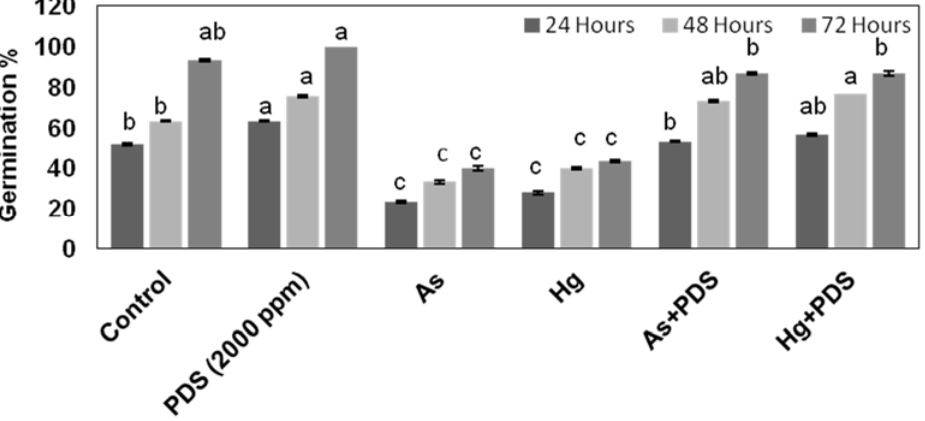
Figure 1. Effect of PDS (2000 ppm) on germination under normal (distilled water), PDS, As and Hg stress and combined application of As + PDS and Hg + PDS. Wheat seeds were subjected to distilled water (control), PDS, As, Hg, As + PDS, and Hg + PDS. Germination rate was observed on days 1–3. PDS (2000 ppm) enhanced seed germination rate and alleviated the adverse effects of As and Hg. Y -axis represents germination% while X -axis represents different treatments. All data were analyzed using one-way ANOVA, the different lowercase alphabets represent the homogenous subsets and it’s indicate the significantly according to Fisher LSD with multiple comparisons test at a significance threshold of p ≤ 0.05 ( n = 10). Each independent experiment was repeated three times.